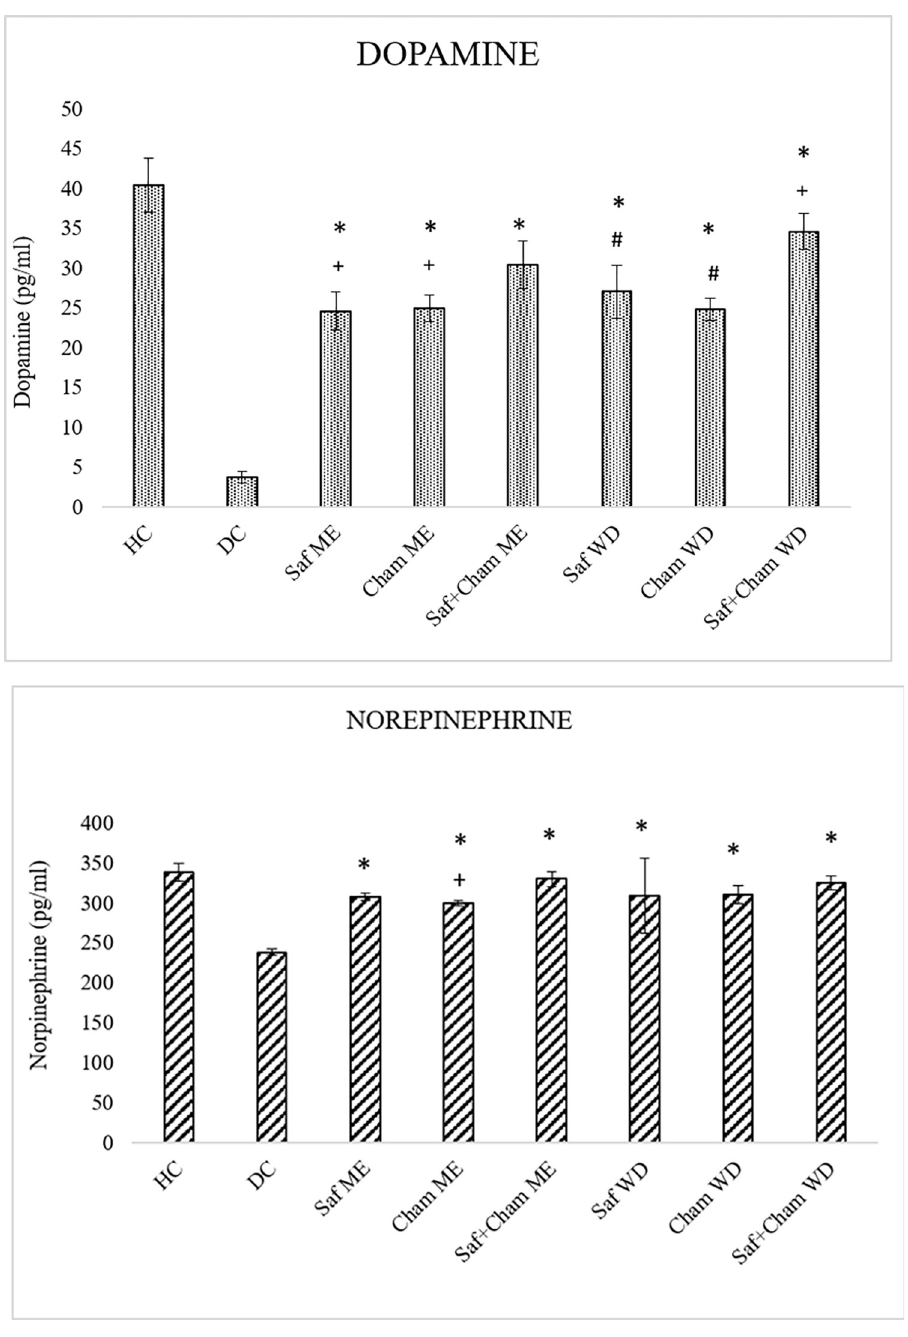
Fig 7. a: Effects of saffron, chamomile and their co-administration in ME and WD on dopamine levels in streptozotocin-induced diabetic rats. Values are presented as means ± SD (n = 10). Tukey’s test significant values: � p < 0.05 from control DC, + p < 0.05 from Saf+Cham ME group, # p < 0.05 from Saf+Cham WD. b: Effects of saffron, chamomile and their co-administration in methanolic extract (ME) and water decoction (WD) on norepinephrine levels in streptozotocin-induced diabetic rats. Values are presented as means ± SD (n = 10). Tukey’s test significant values: � p < 0.05 from control DC, + p < 0.05 from Saf+Cham ME group.